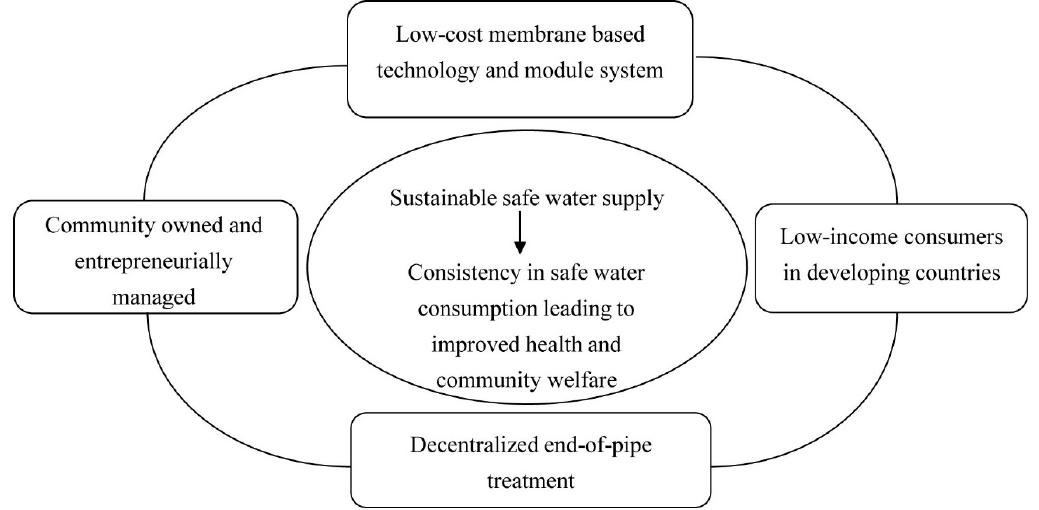
Figure 1. Description of the Safe Water Enterprise concept (edited after Sima and Elimelech